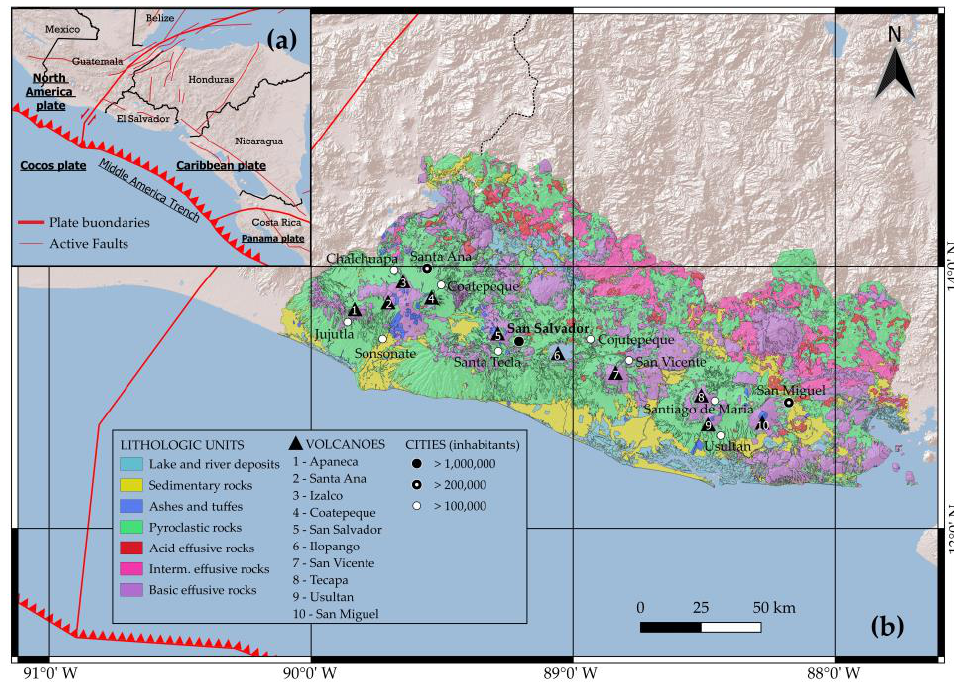
Figure 1. Location and geological setting of the study area. El Salvador is located in Central America, where the Cocos Plate is subducted beneath the Caribbean Plate into the Middle American Trench ( a ); major cities and geological setting of El Salvador, mainly characterized by the volcano chain and by the large outcropping of volcanic rocks ( b ).